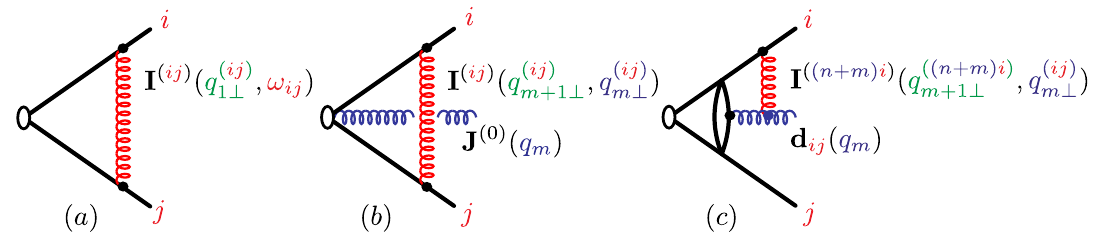
Figure 1 . Relation of limits of the virtual loop insertions to the adjacent dipole emission momenta in the ordered soft gluon emission result. The graphs (a), (b) and (c) respectively correspond to the three lines in eq.